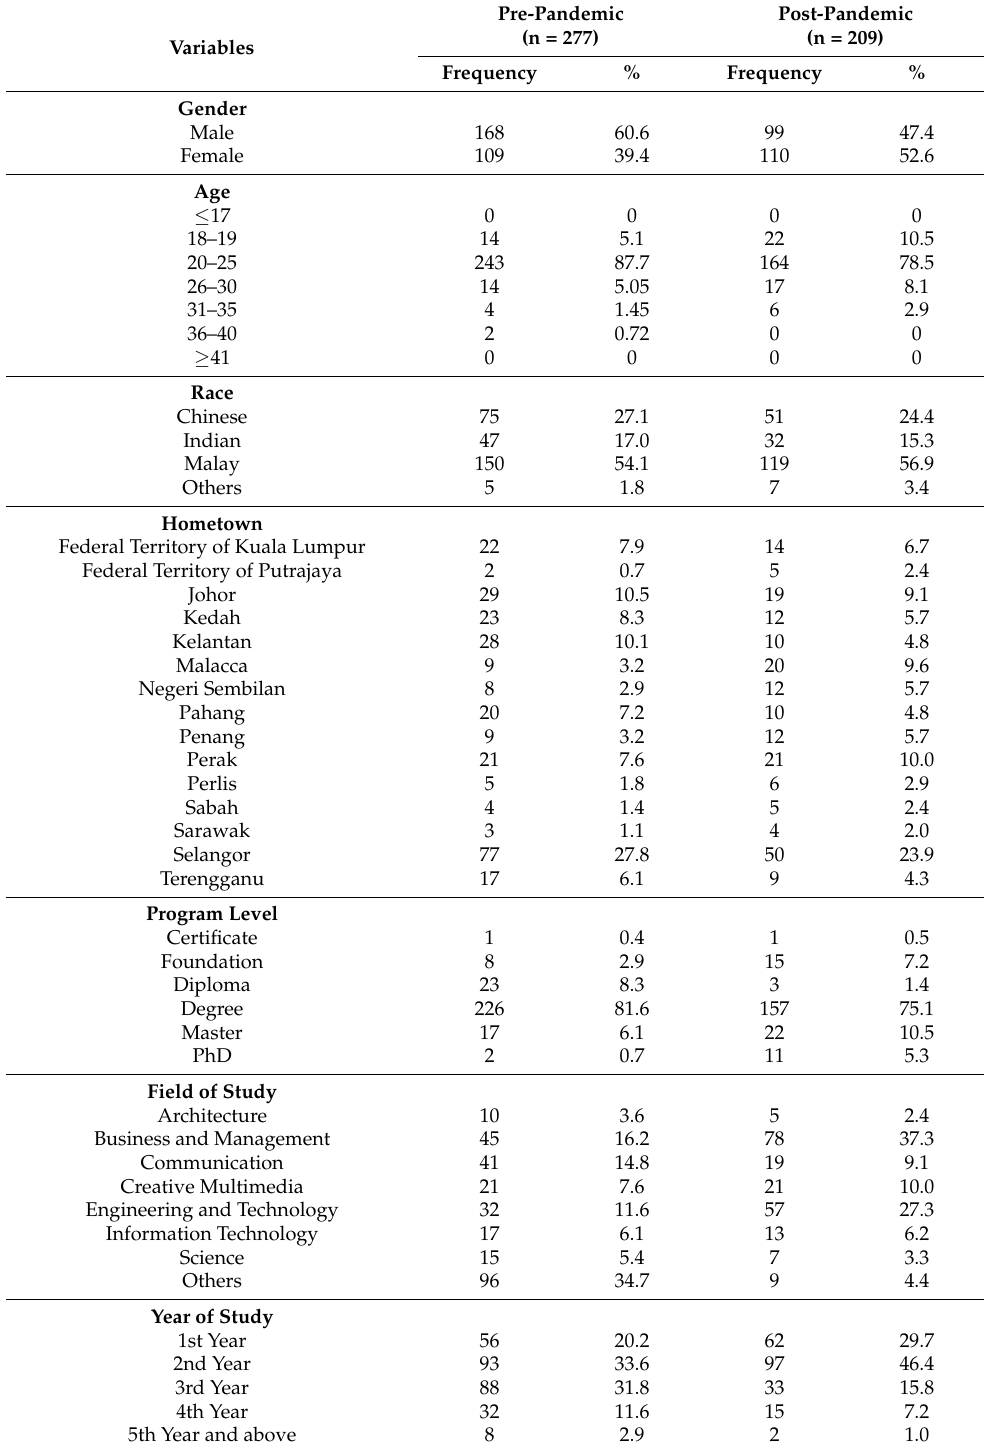
Table 3. Profile of